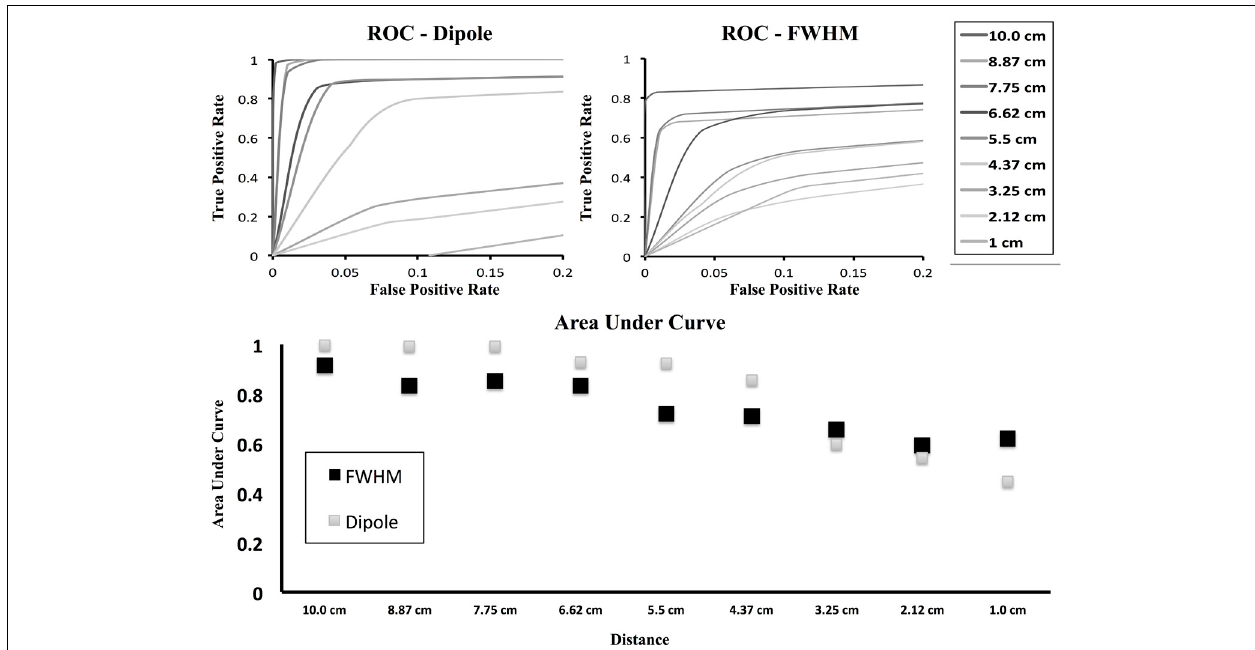
FIGURE 6 | ROC curves for brain simulation with area under curve. ROC curves are shown for decreasing inter-dipole distance in the brain simulations for both the cluster containing the originally activated dipole as well as the